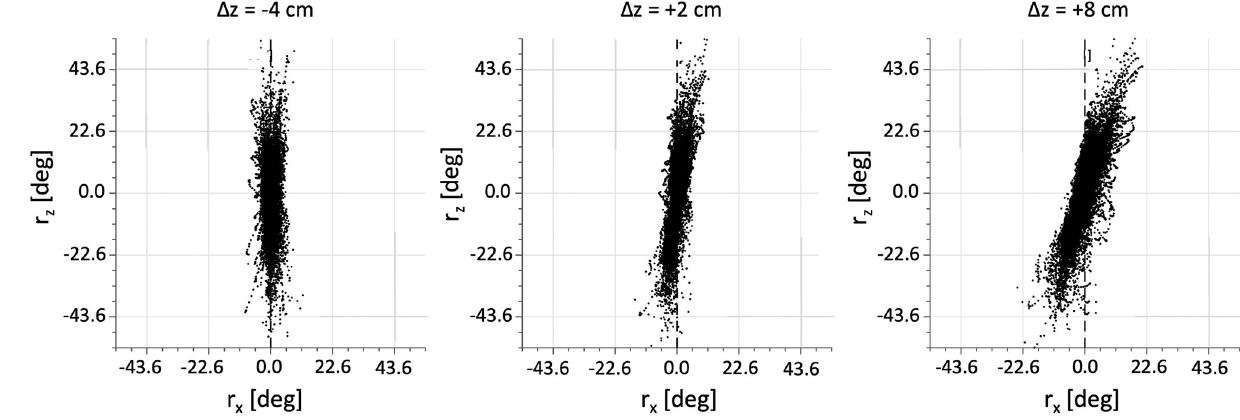
Fig 15. Eye orientations in the xz-plane for all saccades, for three different vertical shifts, Δ z , of the cranial muscle insertion points with respect to the horizontal midplane of the eye. Note that the orientation of LP tilts as a function of the shift.